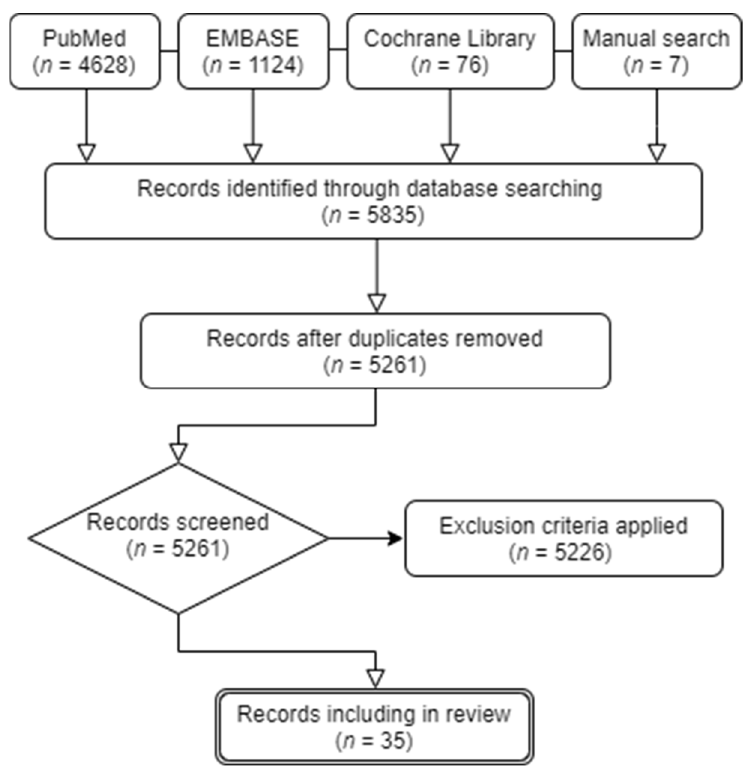
Figure 1. Diagram showing selection of studies for review.